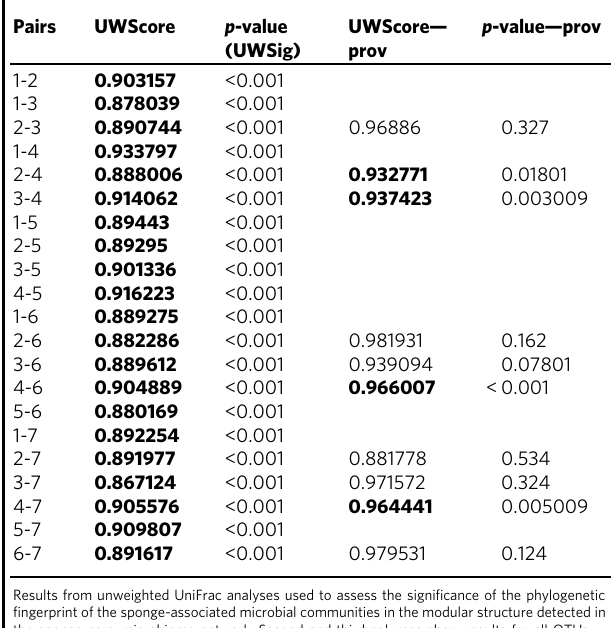
Emptycellsrepresentsituationswheremodulesidenti fi edinthenetworkhadnoprovincialhubs. All signi fi cant scores (UniFrac p -value<0.05) are highlighted in